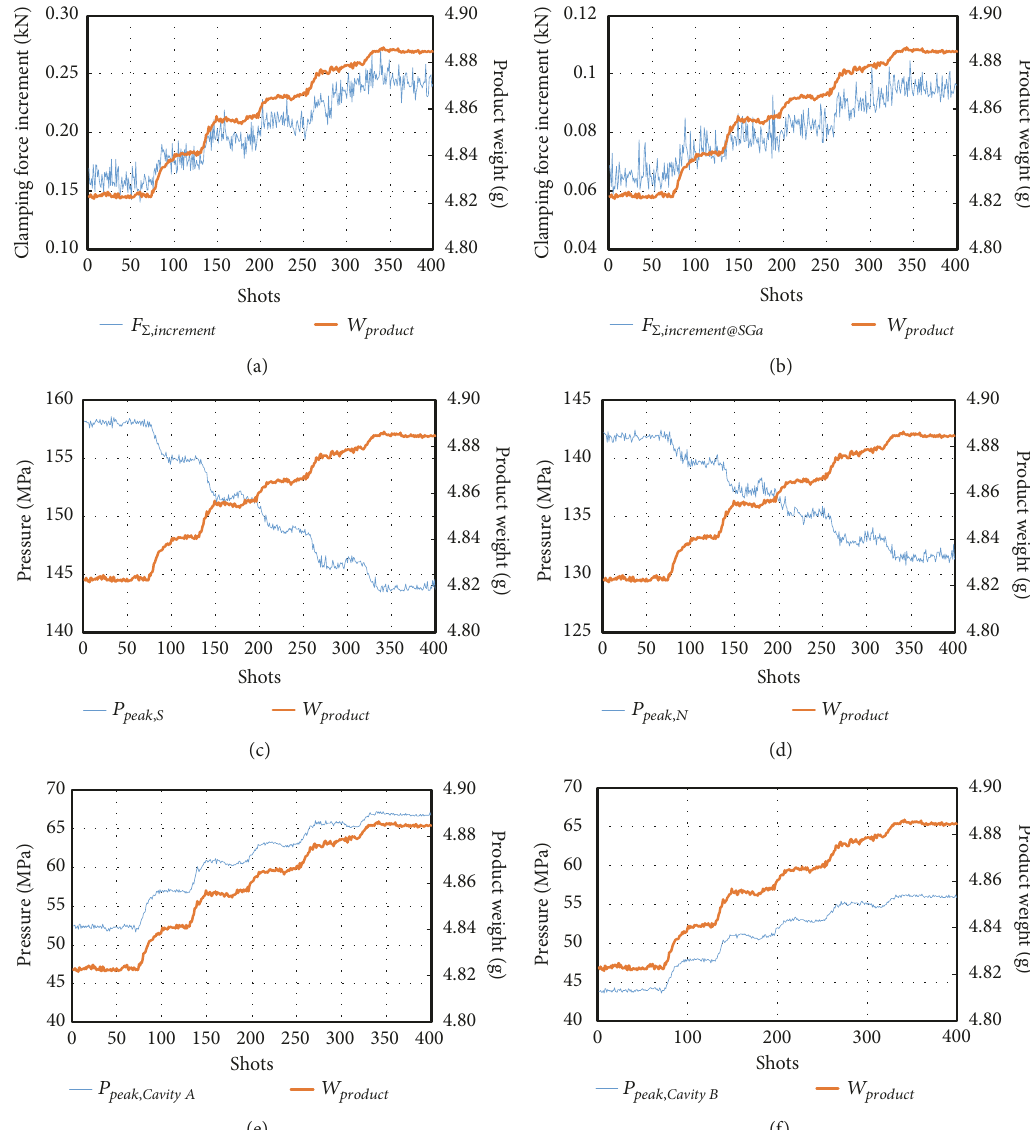
Figure 16: Melt quality fluctuation as revealed by force and pressure quality